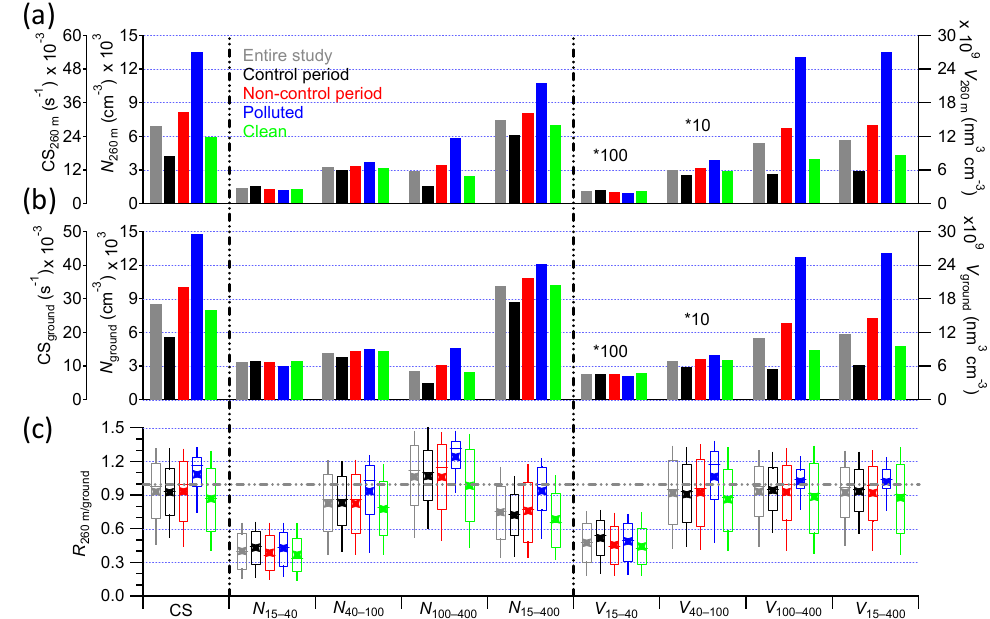
Figure 4. Average number and volume concentrations and CS at (a) 260m and (b) ground level for the entire study and four different periods. Panel (c) shows the box plots of the ratios of 260m to ground level. The volume concentrations of small and large Aitken-mode particles are enhanced by factors of 100 and 10, respectively, for clarity.